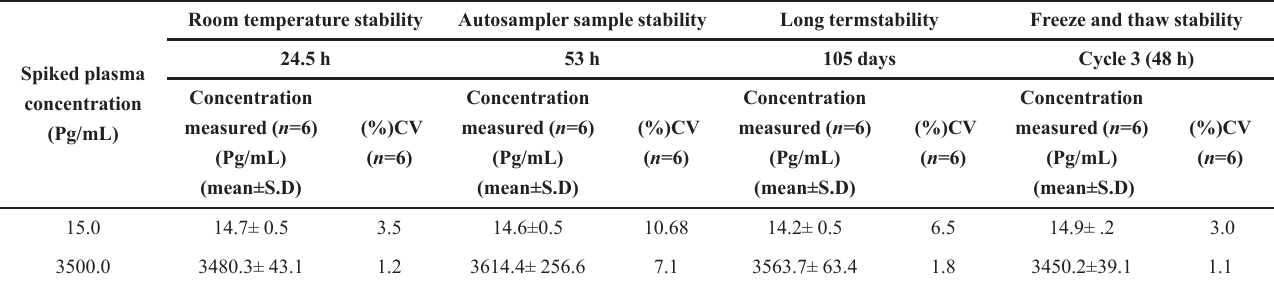
TABLE III - Stability of the samples Room temperature stability Autosampler sample stability Long Spiked plasma concentration (Pg/mL)